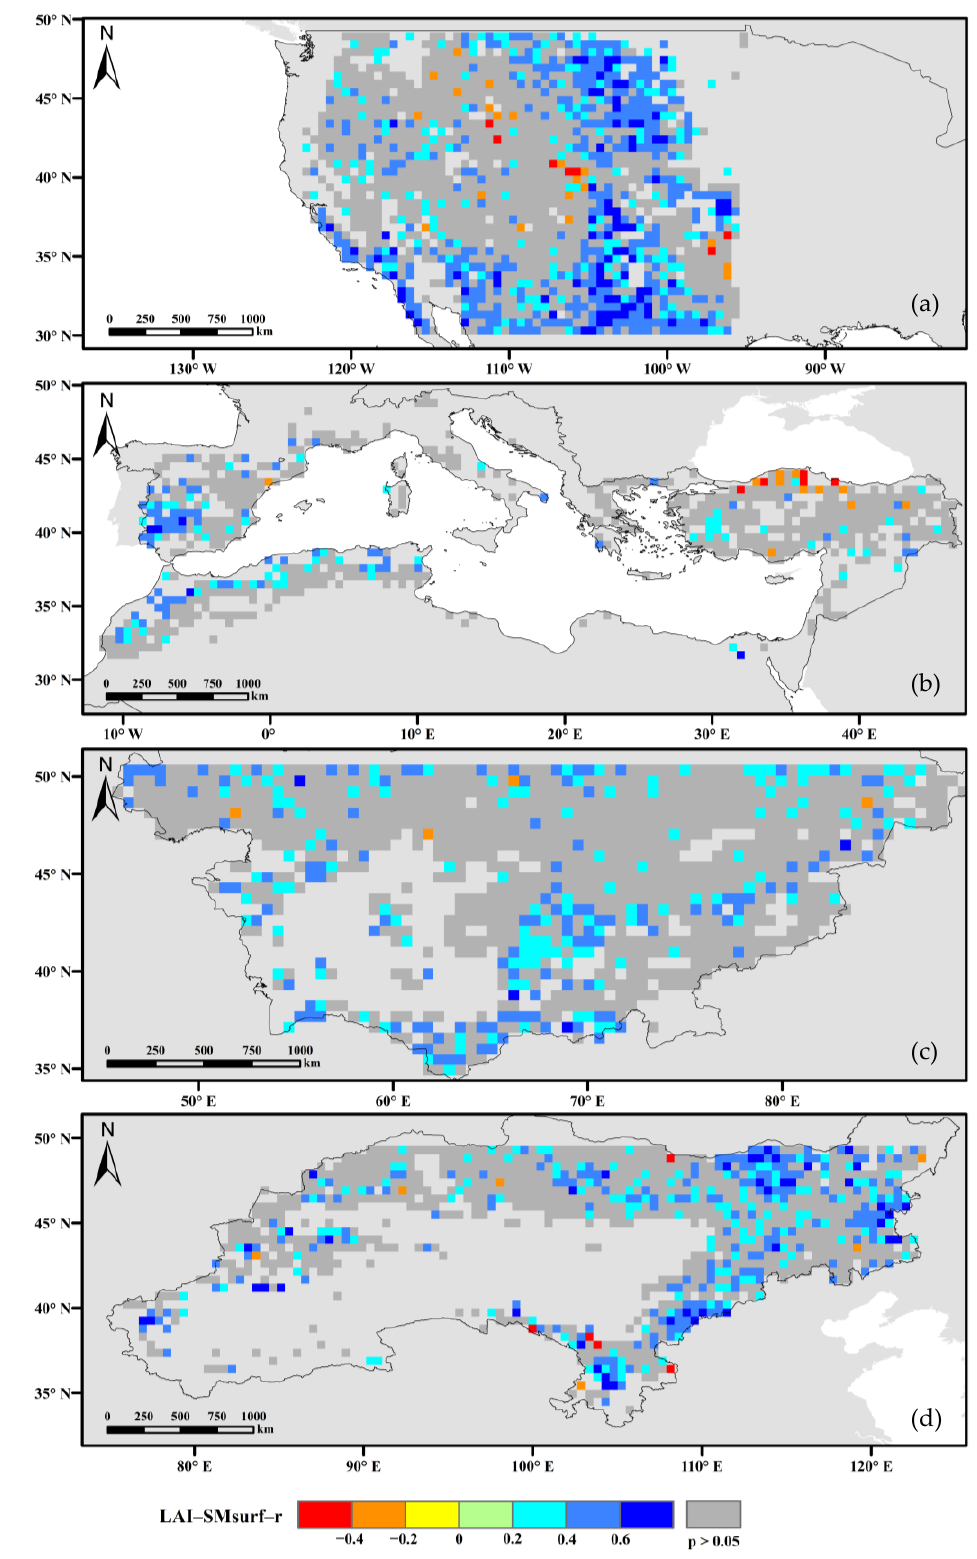
Figure A5. Relationship between the LAI and surface soil moisture from 1981 to 2018 ( p < 0.05) in